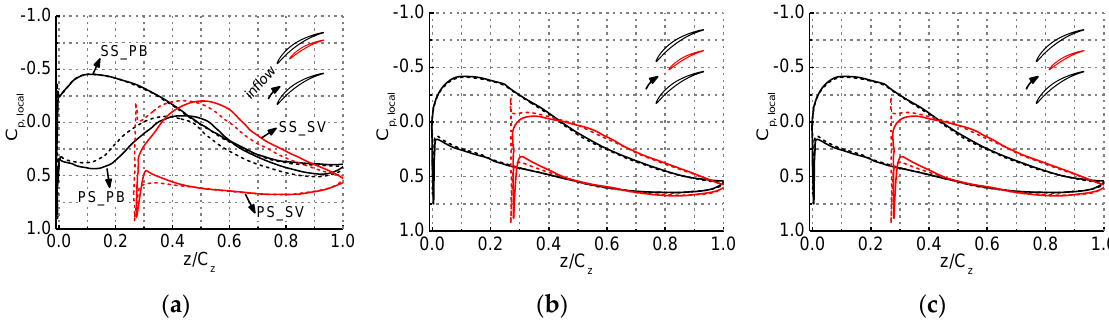
Figure 7. Blade surface pressure distribution for case two (Dashed lines denote the original designs, and solid lines denote the “impact-free entry” designs). ( a ) PP = 0.83; ( b ) PP = 0.50; ( c ) PP = 0.22. On the other hand, it is indicated that the pressure distribution is considerably influenced by PP.